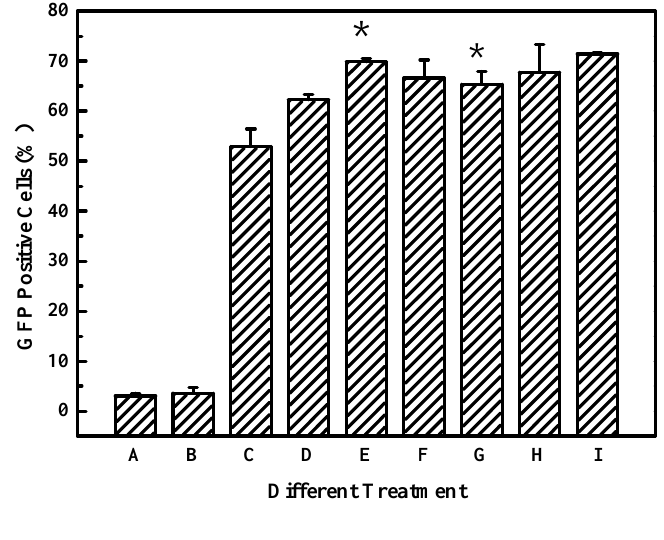
Figure 5. Comparison of the optimal transfection efficiency of cross-linked PEIs and 25-kDa PEI in B16F10 cells. Cells were transfected using optimal conditions established for each vector. *, p <